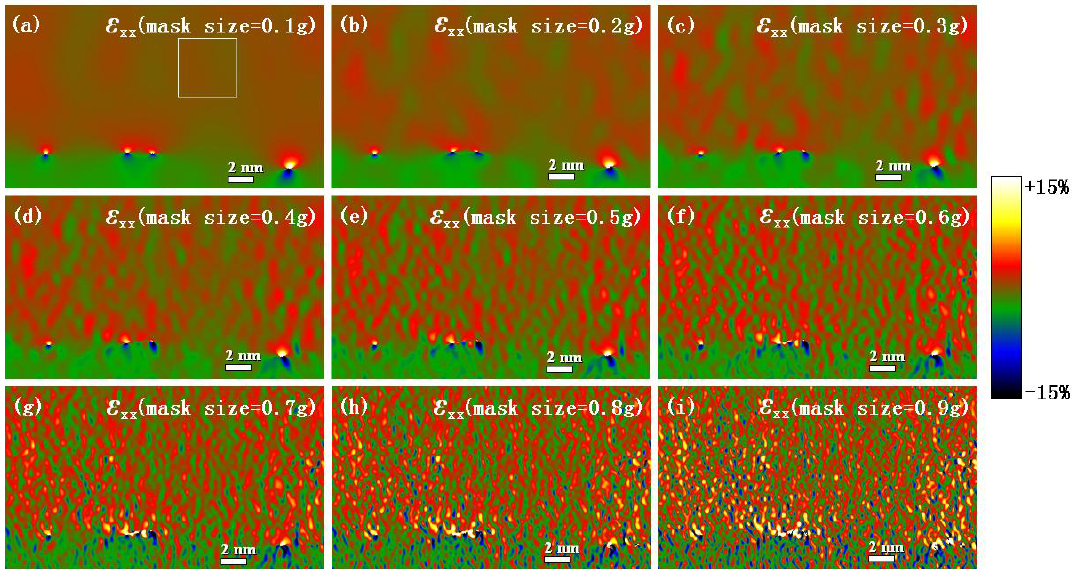
Figure 2. Experimental strain components ε corresponding to the different mask sizes determined by geometric phase analysis